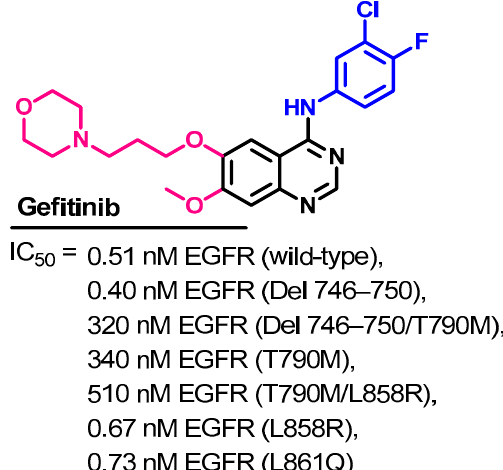
Figure 31. Kinase inhibitory activities of gefitinib.